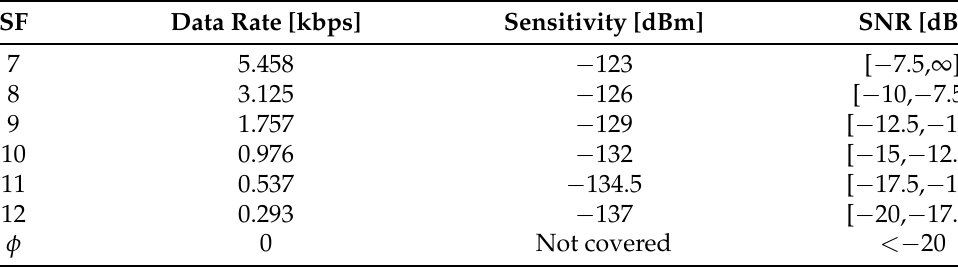
the packets to the server. Figure 2 presents a typical architecture of such a